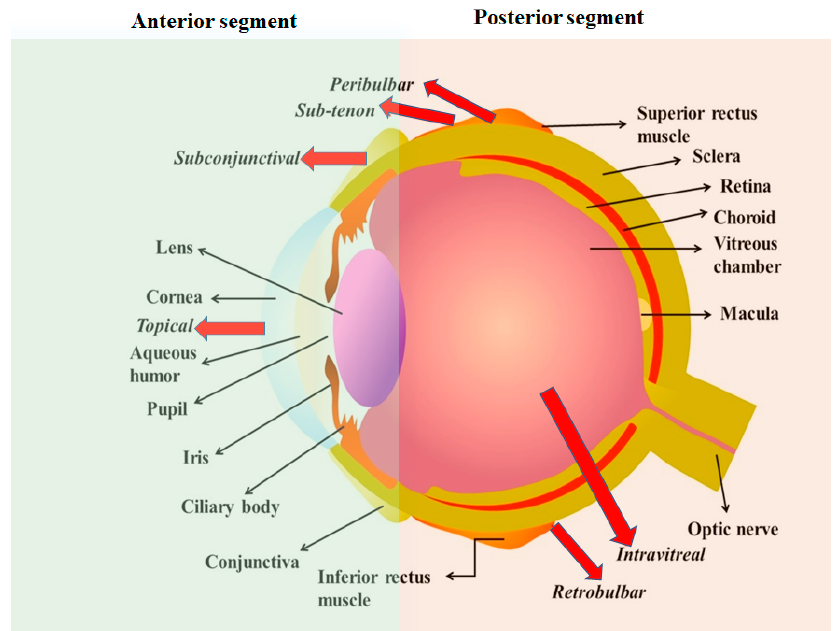
Figure 1. Anatomy of the human eye and routes of drug administration. Black arrows show different parts of human eye and red arrows show various routes of drug administration. Reproduced with permission from reference [5] , copyright 2017 Elsevier B.V.